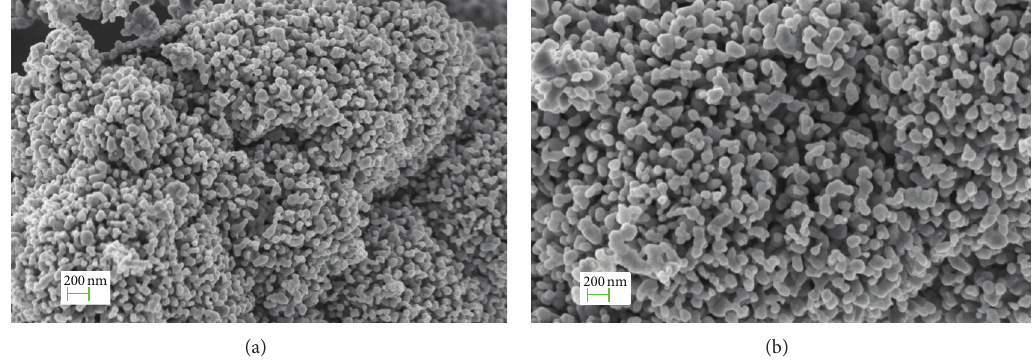
Figure 3: FE-SEM images of cobalt ferrite. (a) 64 KX and (b) 100KX.